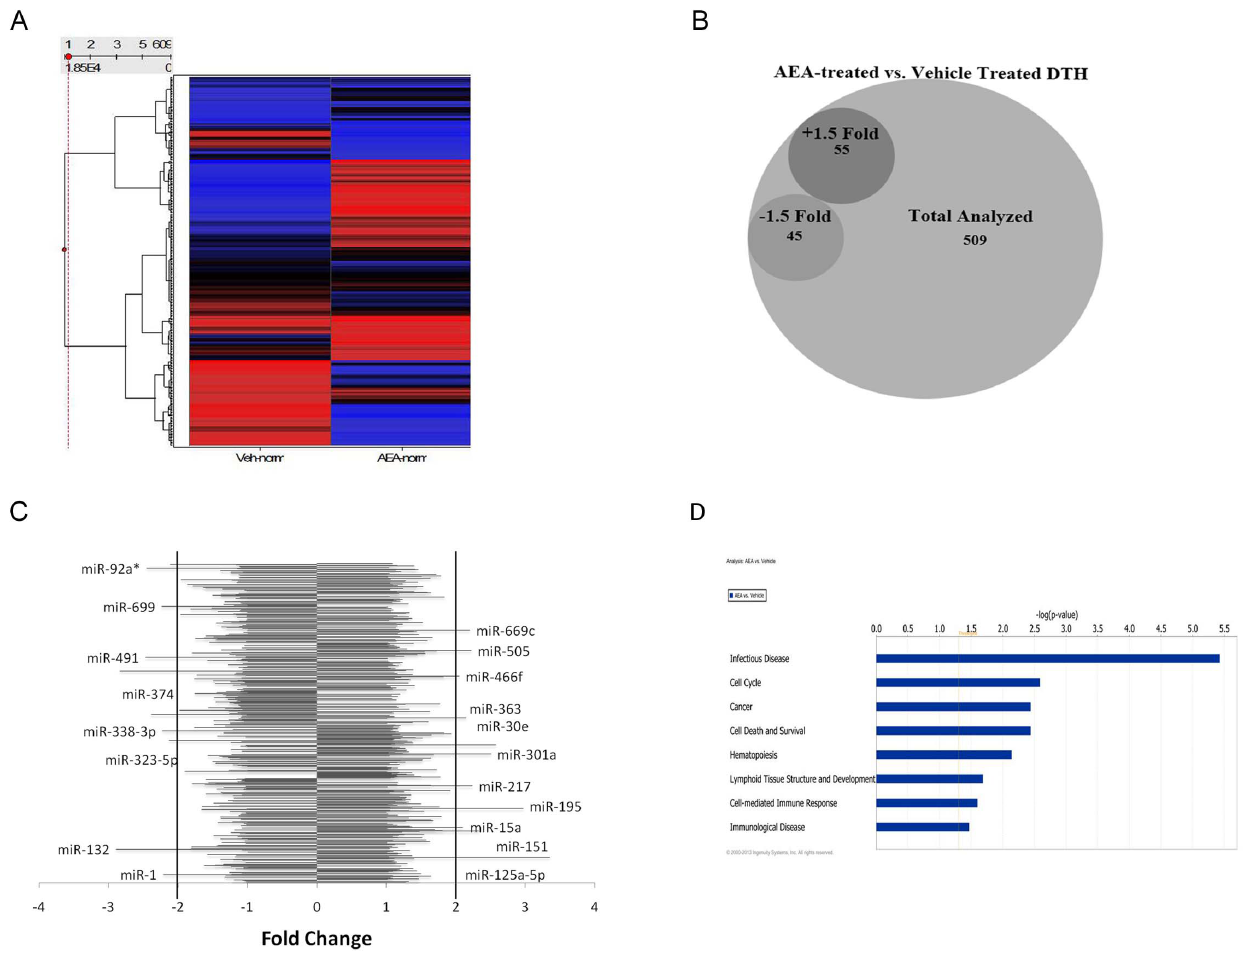
Figure 5. Effect of AEA on miRNA induction in mice with mBSA-induced DTH: Affymetrix miRNA array analysis. [A] Heat map of miRNA expression patterns. RNA was isolated from five pooled popliteal lymph nodes of mBSA-sensitized mice rechallenged with mBSA and treated with either AEA or Vehicle. The samples were analyzed using Affymetrix miRNA 1.0 microarray. The values for each sample were generated by normalizing the expression of the microRNA to each sample. Ward’s Method was used for clustering patterns and the samples were ordered by the Input Rank method. [B] AEA induced differential regulation of several miRNA species, as enumerated by the Venn diagram. [C] The most differential regulated miRNA expressed as a bar chart. [D] Ingenuity Pathway Analysis of the most differentially regulated biological